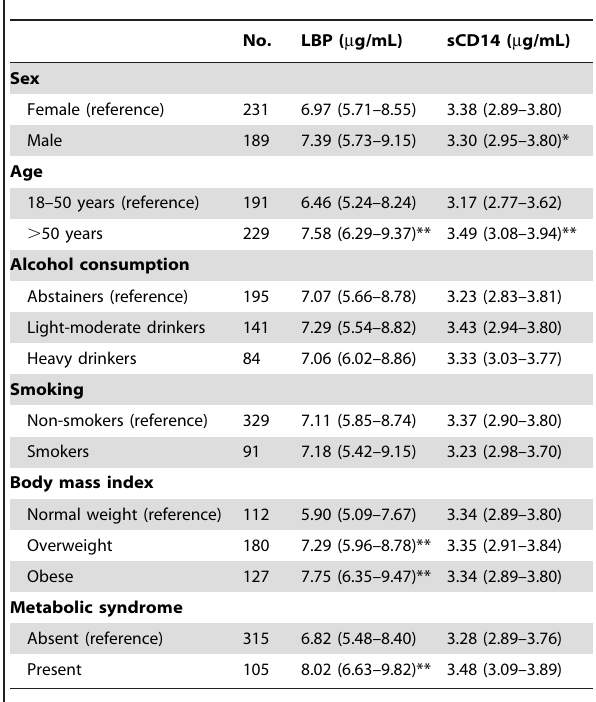
Table 1. Serum concentrations of lipopolysaccharide-binding protein (LBP) and soluble CD14 (sCD14) in relation to demographic variables, lifestyle factors, and metabolic